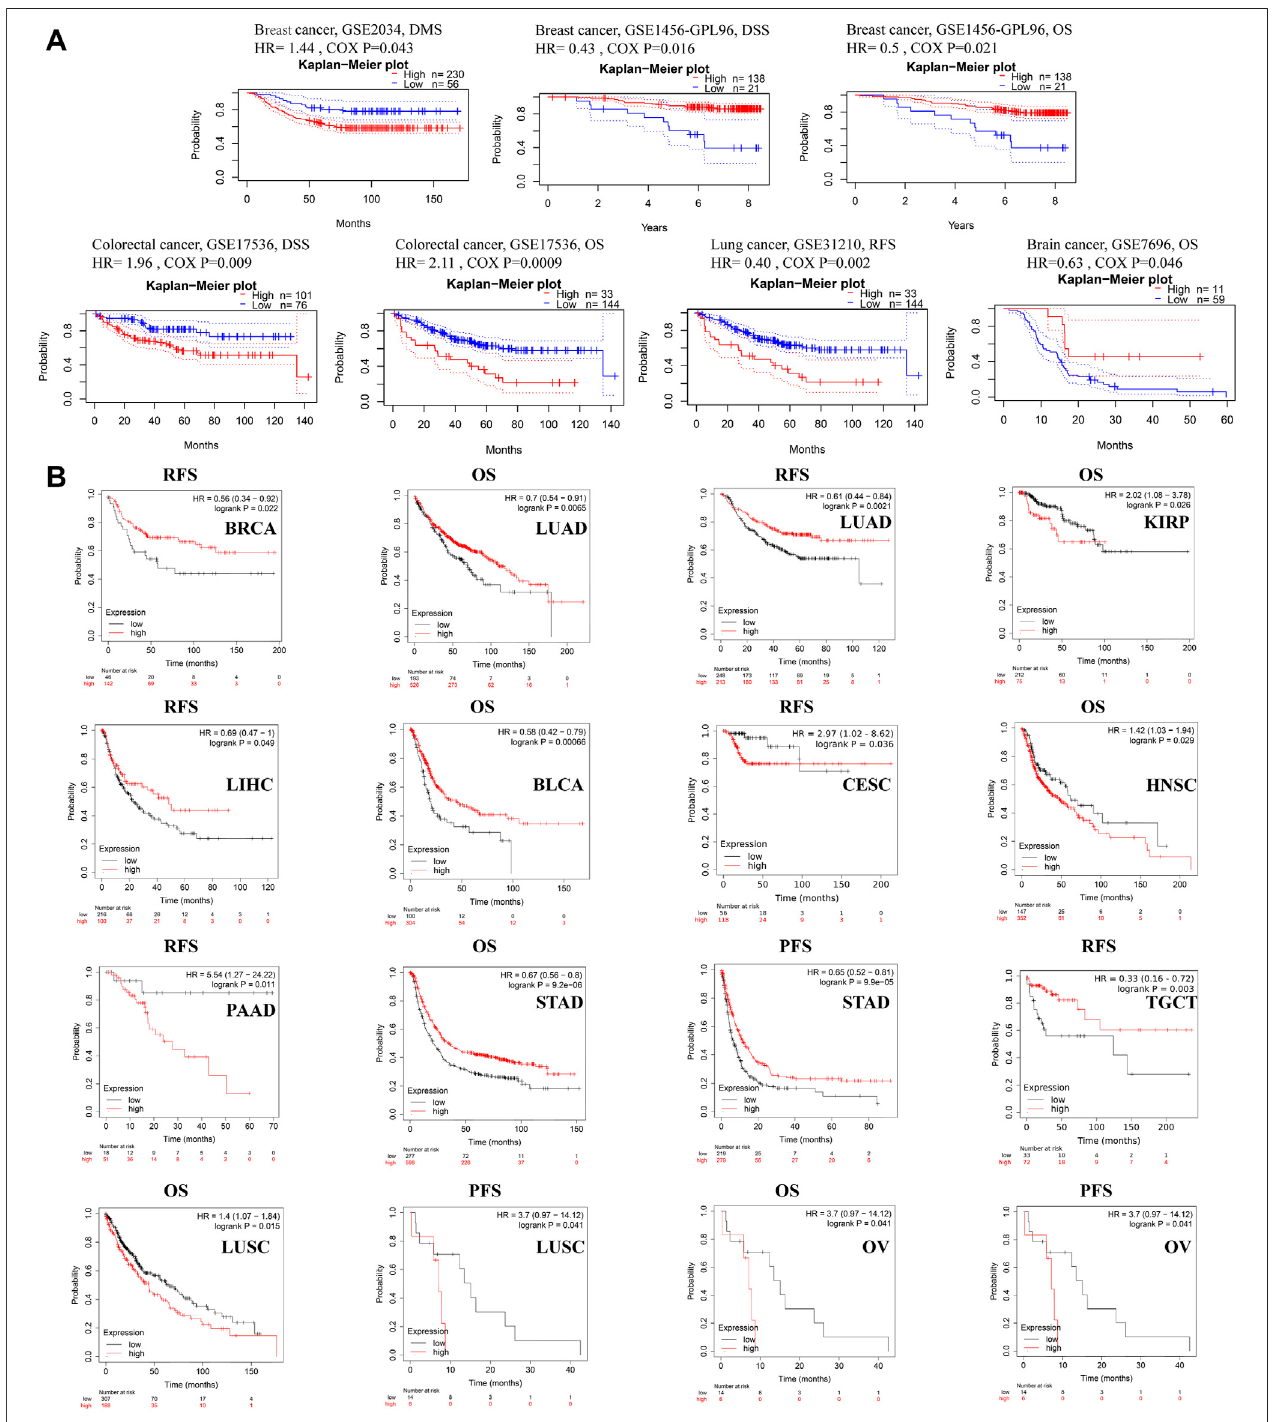
FIGURE 3 | Survival data evaluating the prognostic value of ACSL4. (A) . Correlation between ACSL4and prognosis ofvarious types of cancer in the PrognoScan. DMFS ( n (cid:1) 286) in breast cancer cohort GSE 2034. DSS (n (cid:1) 159) in breast cancer cohort GSE1456-GPL96. OS ( n (cid:1) 159) in breast cancer cohort GSE1456-GPL96. DSS ( n (cid:1) 177) in colorectal cancer cohort GSE17536. OS ( n (cid:1) 177) in colorectal cancer cohort GSE17536. RFS ( n (cid:1) 204) in lung cancer (Adenocarcinoma) cohort GSE31210.OS( n (cid:1) 70)inbraincancer(Glioblastoma)cohortGSE7696.DMFS,distantmetastasis-freesurvival;OS,overallsurvival;DSS,disease-speci fi csurvival;